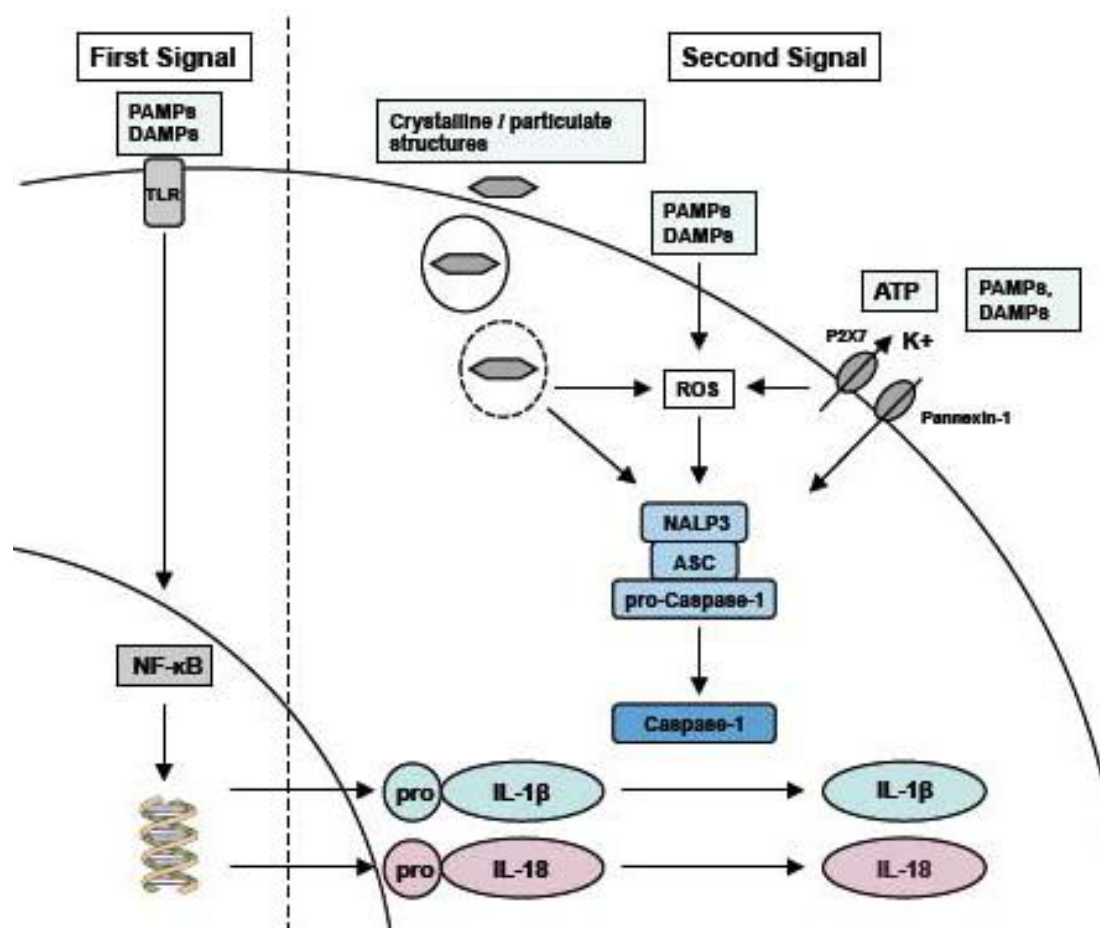
FIGURE 2. First and second signal for inflammasome activation. For inflammasome activation, two signals are required. The first one, which can be conducted through PAMPs or DAMPs, leads to the NF-κB– dependent transcription and translation of pro–IL-1β and pro–IL-18. For the second signal, several mechanisms have been suggested. Extracellular ATP leads to a P2X7-dependent pore formation in the cell membrane, which entails a potassium efflux from the cell. This efflux leads to emplacement of large-pored pannexin-1 channels into the membrane, through which PAMPs and DAMPs can now access the cell and directly activate NLRP3. Larger molecules, such as crystalline or particulate ligands, are incorporated by phagocytosis. After rupture of the phagolysosome, they can again directly bind and activate the inflammasome. ROS are generated after exposure to PAMPs and DAMPs, but also through the ATP- dependent potassium efflux and lysosomal rupture, and can activate the inflammasome via the ROS-sensitive ligand, thioredoxin-interacting protein. Most likely, all mechanisms occur concomitantly. The second signal results in the cleavage of pro–IL-1β and pro–IL-18 into the active forms. ATP, adenosine triphosphate; DAMPs, danger-associated molecular patterns, ROS, reactive oxygen